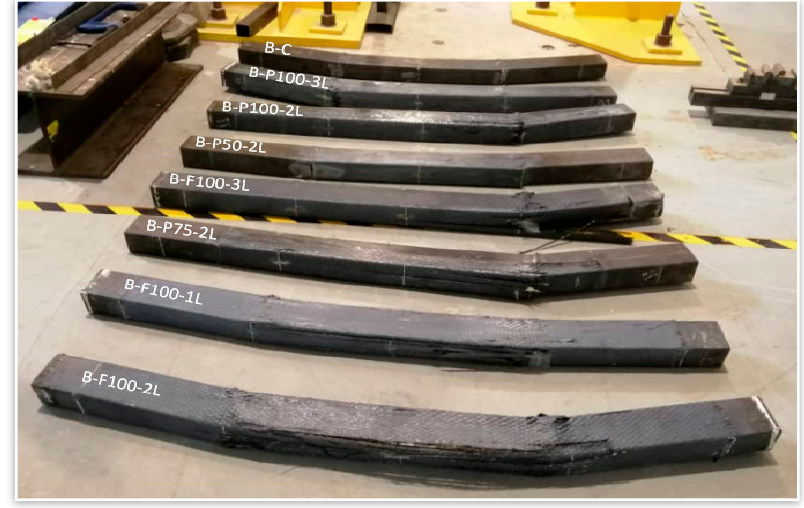
Figure 14. Failure modes of all tested HPCFDST samples.